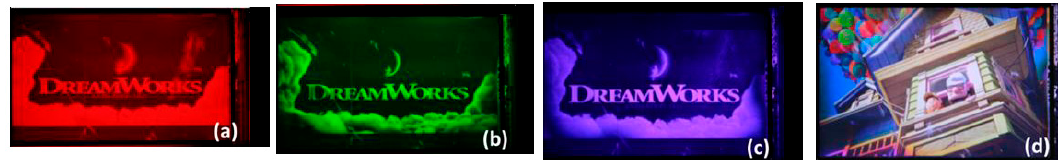
Figure 16. Prototype of the field-sequential color video display, based on the ESHFLC mode. R, G, B, respectively, sub-frame images: ( a ), ( b ), ( c ). Full-color image ( d ).